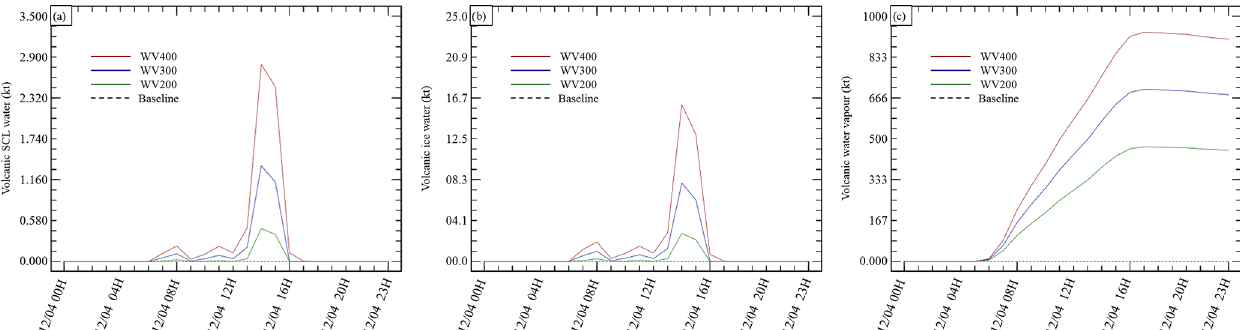
Figure A4. Water apportionment between its various states: (a) SCLW, (b) ice and (c) water vapour.